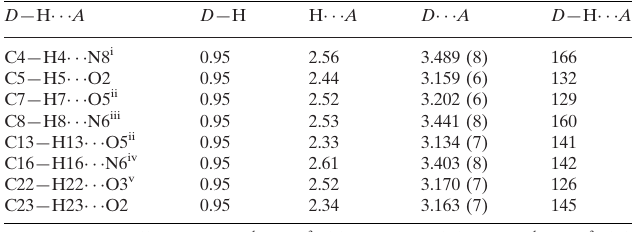
Hydrogen-bond geometry (A˚ , (cid:2)